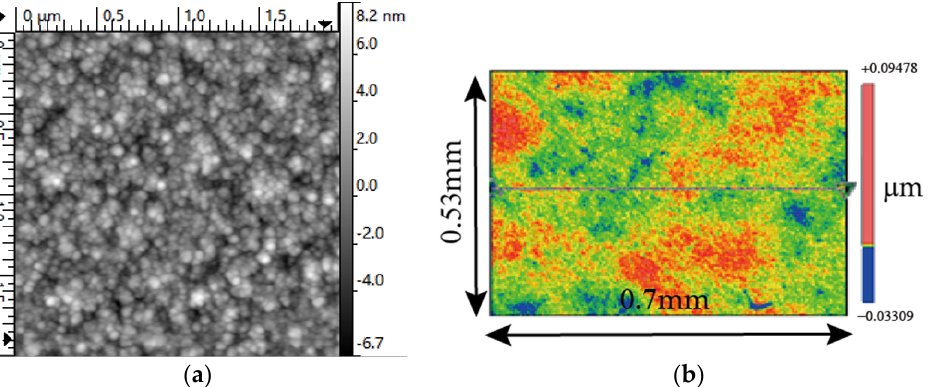
Figure 4. Topography measurement result of the superpolished sample shown in Figure 3. ( a ) The AFM measurement result, ( b ) the WLI measurement result with 10 × objective.